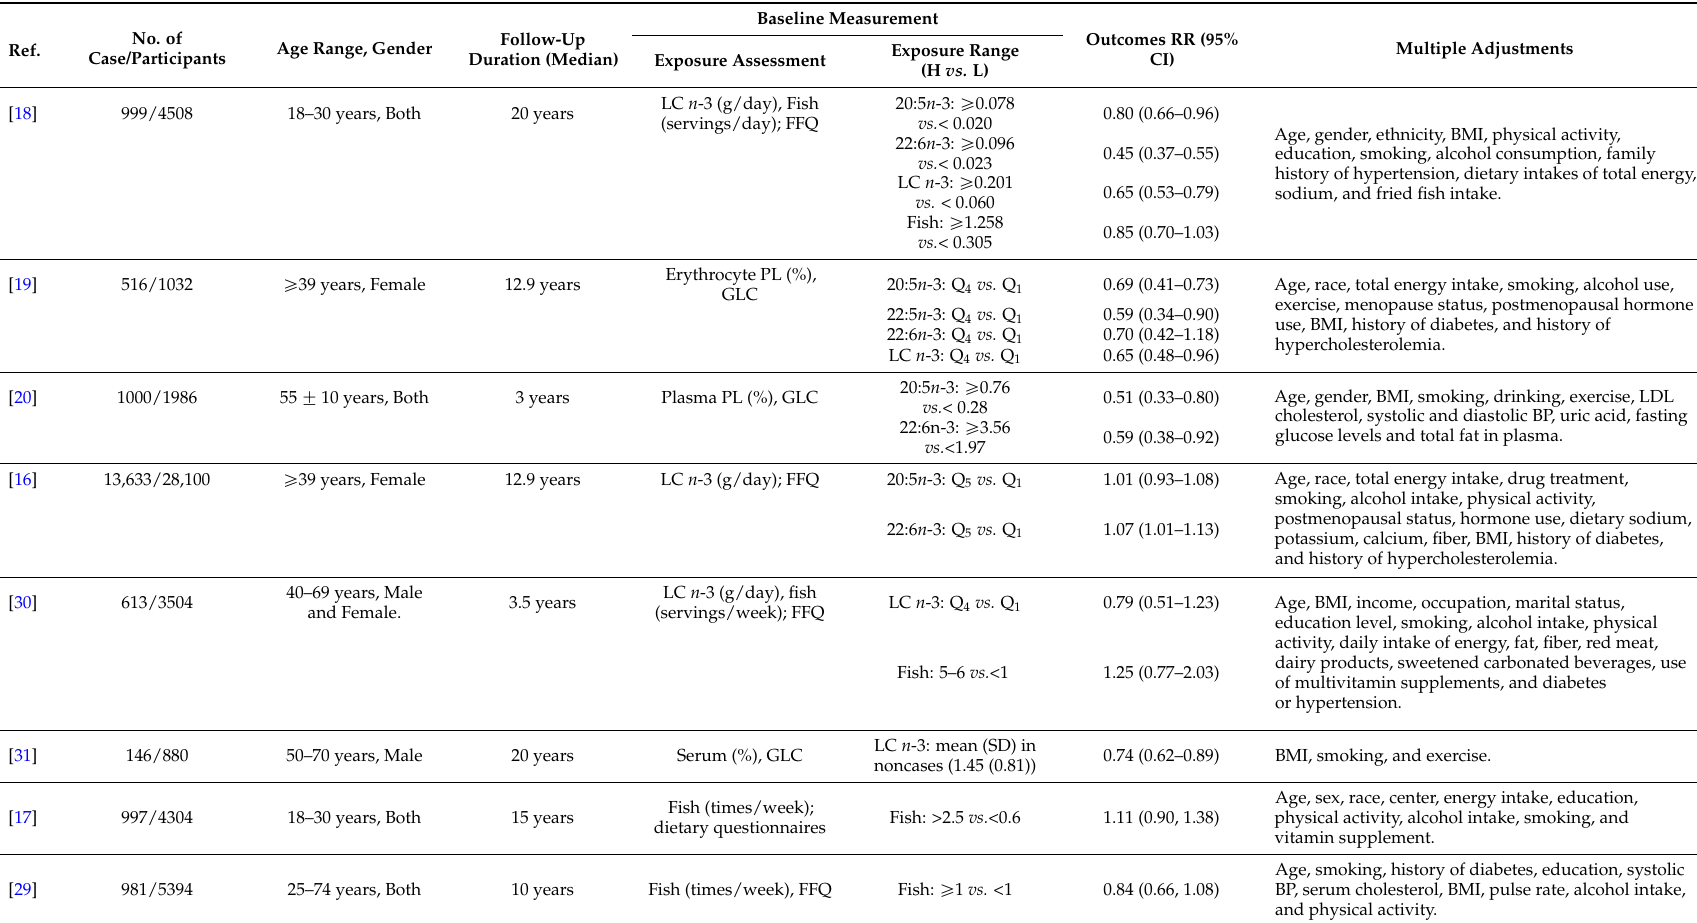
Table 1. Baseline characteristics of individual prospective cohort